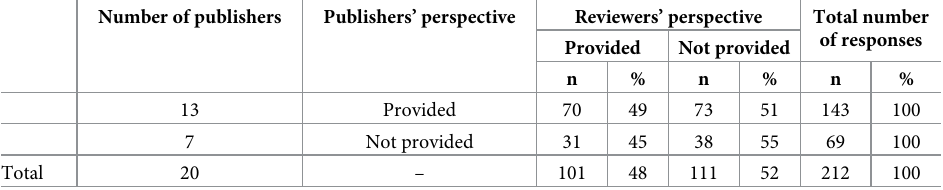
Table 1. A comparison of reviewers’ responses ( n = 212) on whether publishers provide evaluation criteria, along with corresponding publishers’